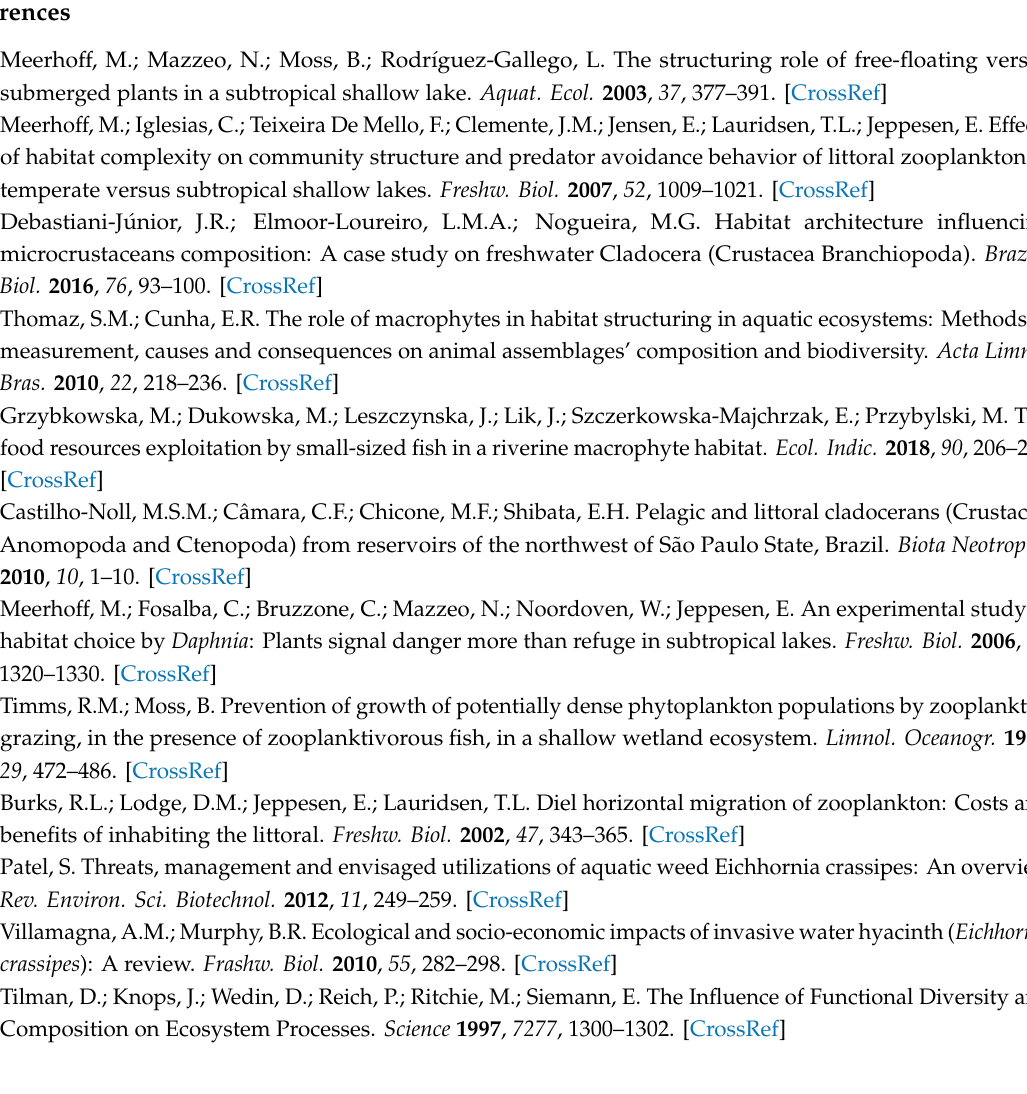
Figure S1: Average of limnological variables in mesocosms with and without macrophytes. Table S1: Statistical results of modeling analysis for S (species richness) and the independent variables. Table S2: Statistical results of modeling analysis for H’ (Shannon-Weaver species diversity) and the independent variables. Table S3: Statistical results of modeling analysis for FRic (functional richness) and the independent variables. Table S4: Statistical results of modeling analysis for FEve (functional evenness) and the independent variables. Table S5: Statistical results of modeling analysis for FDis (functional dispersion) and the independent